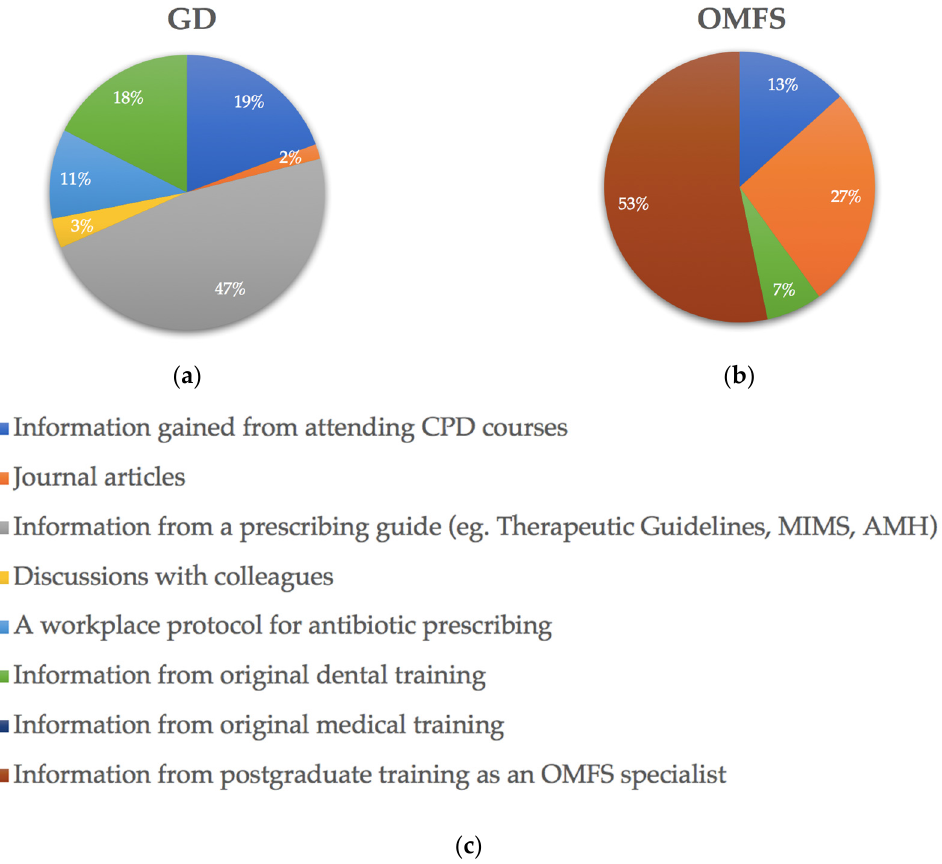
Figure 1. Most important factor or resource affecting practitioners’ prescribing decisions. ( a ) GD group ( n = 60); ( b ) OMFS group ( n = 18); ( c ) Key.